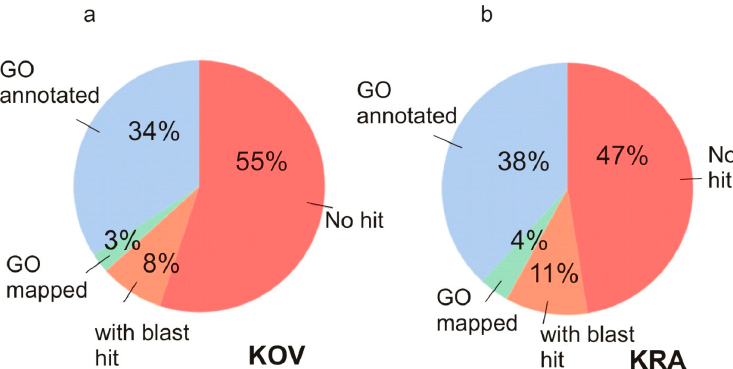
Figure 2. Proportion of the genes with GO annotations in ( a ) the KOV transcriptome, ( b ) in the KRA transcriptome.